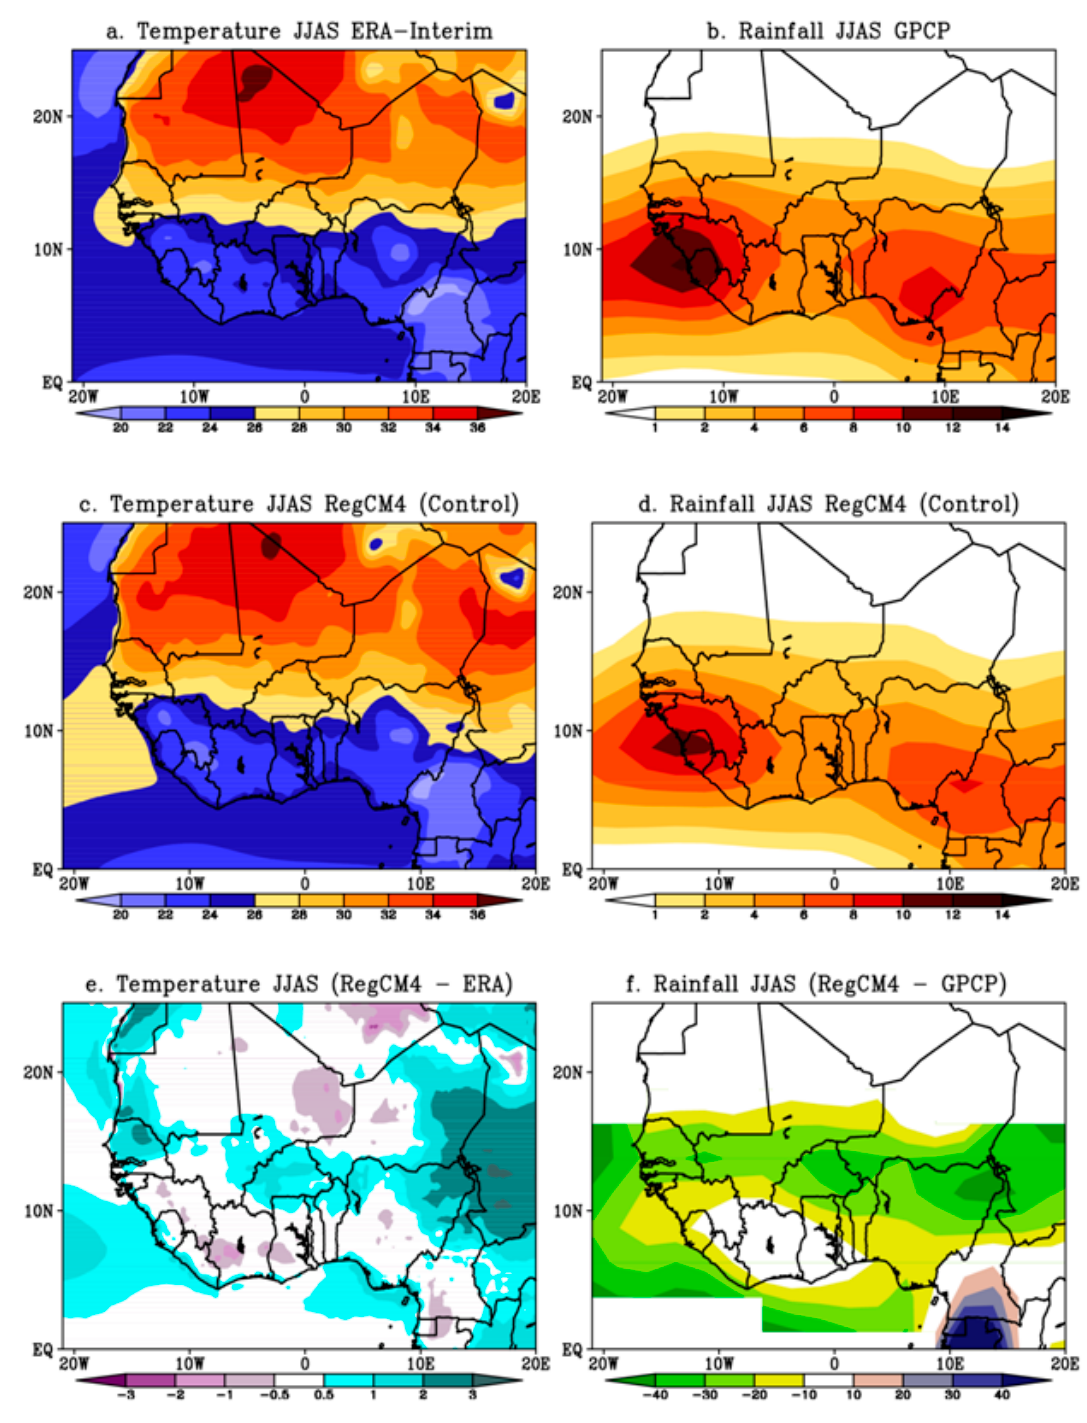
Figure 2. Mean summer surface temperature (left) and rainfall (mm/day) (right) averaged from 1980 to 2009 over West Africa: ( a ) ERA-Interim, ( b ) Global Precipitation Climatology Project (GPCP), ( c , d ) RegCM4, ( e ) RegCM4–ERA-Interim and ( f ) Relative bias of RegCM4 with respect to GPCP from June to September (JJAS).